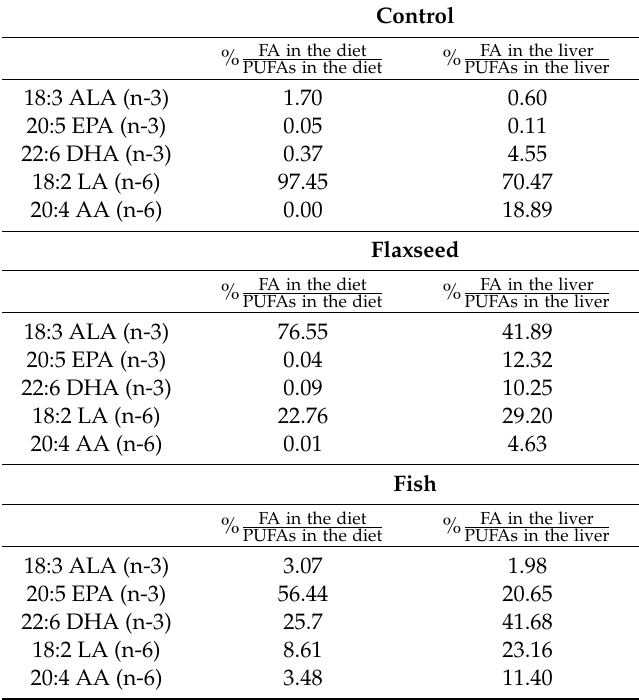
Table 4. Comparison between FA profiles of liver and diets. Control % FA in the diet PUFAs in the